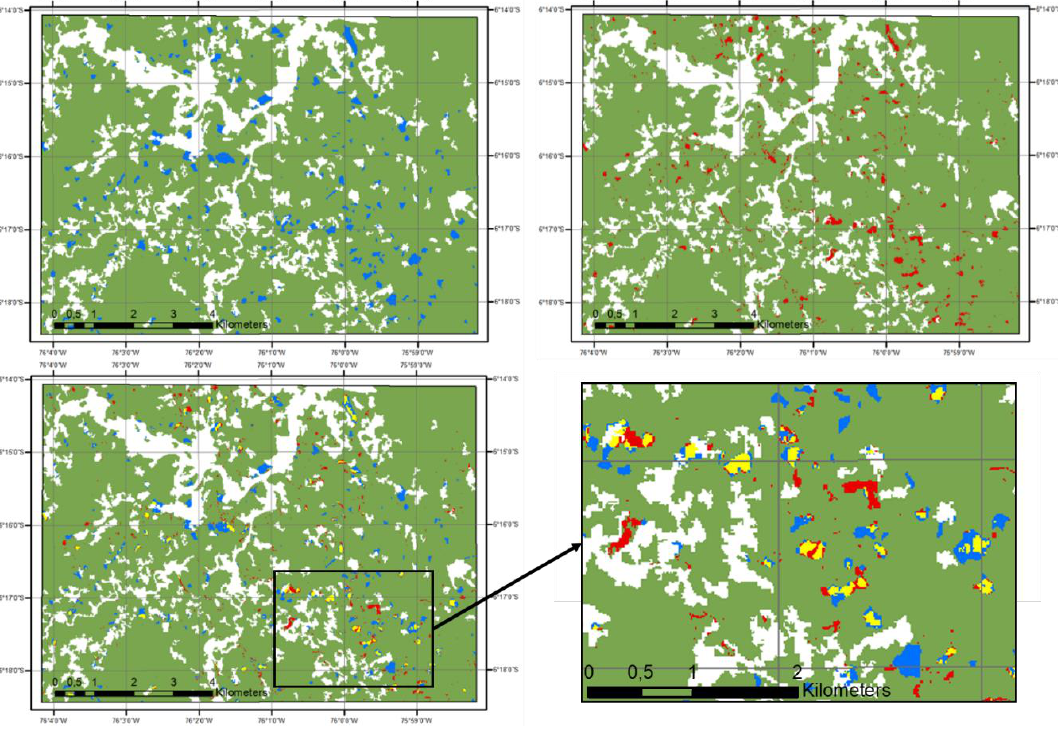
Figure 7. Comparison of forest disturbance detection results in Peru showing the high complementarity of S-1 and optical data. Top left: “S1 Only” map; top right: “”Optical only” map; bottom left: Union of “S1 Only” and “Optical Only” maps (yellow areas are detected by both approaches); bottom right: enlarged area of “Union” map (black rectangle). Table 2. Area of detected forest disturbances at the Peru validation site for each mapping approach.